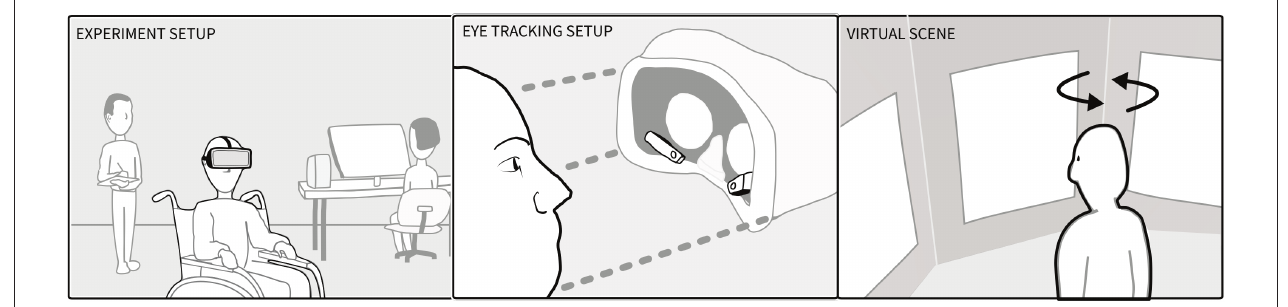
FIGURE 1 | (Left) Experimental setup showing note taker, technician and the participant who wore a head-mounted display whilst sitting in a wheel chair. (Middle) Participants wore an HTC Vive with Pupil Labs eye tracking cameras mounted inside. (Right) The virtual museum contained the participant and three images to the left ( − 48 ◦ ), right ( + 48 ◦ ), and middle (0 ◦